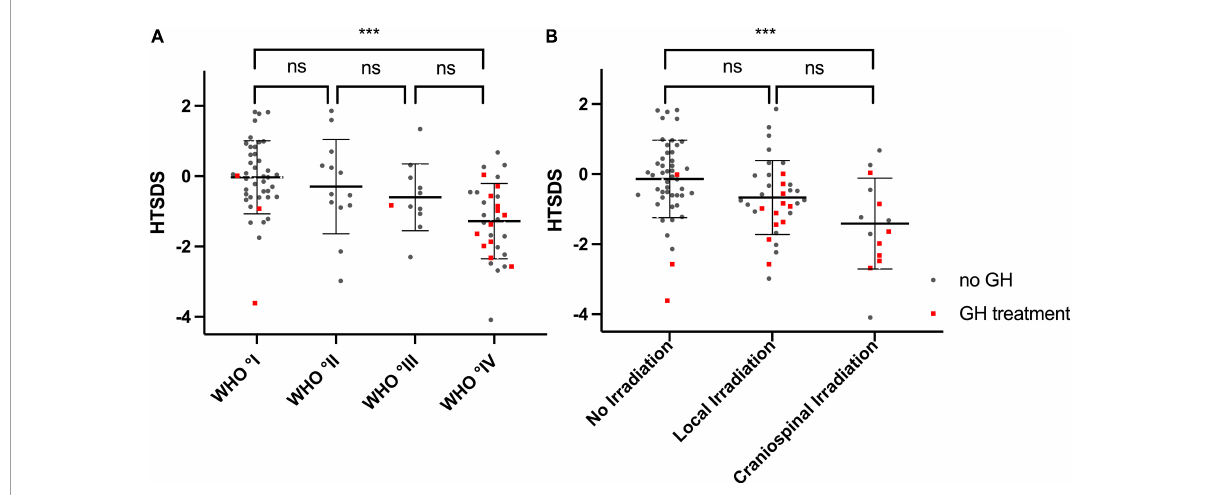
FIGURE5 Height SDS and WHO Degree, Height SDS and irradiation treatment: (A) Height SDS is decreasing with increasing WHO degree of the tumors ( P < 0.001 Kruskal–Wallis test). (B) Height SDS is lower in patients who received irradiation ( P < 0.001 Kruskal–Wallis test), likely due to the increased percentage of patients with a GH deficiency in that group. Lines indicate mean and sd. Red dots represent individuals who receive(d) GH treatment. *** p <